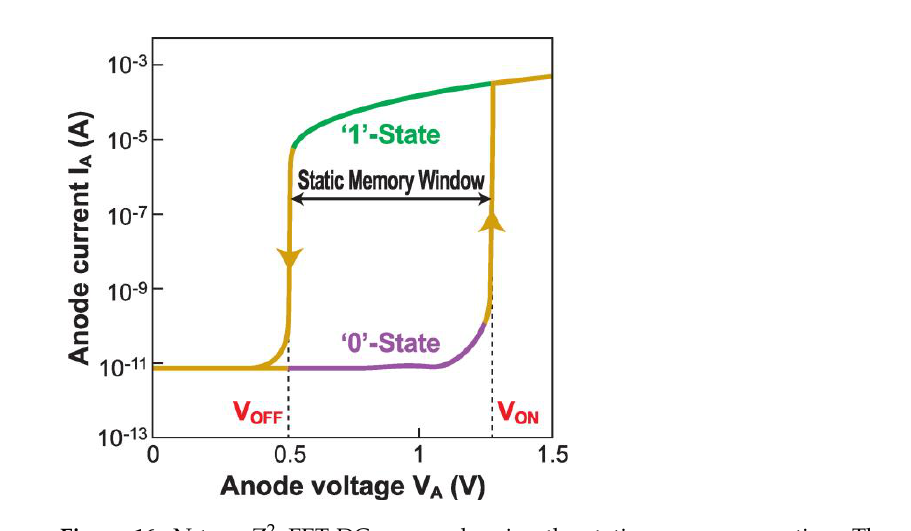
Figure 16. N-type Z 2 – FET DC curves showing the static memory operation. The anode current needed to hold the ‘ 1 ’ -state limits the application of Z 2 – FET-based single-transistor SRAM to low-density chips.